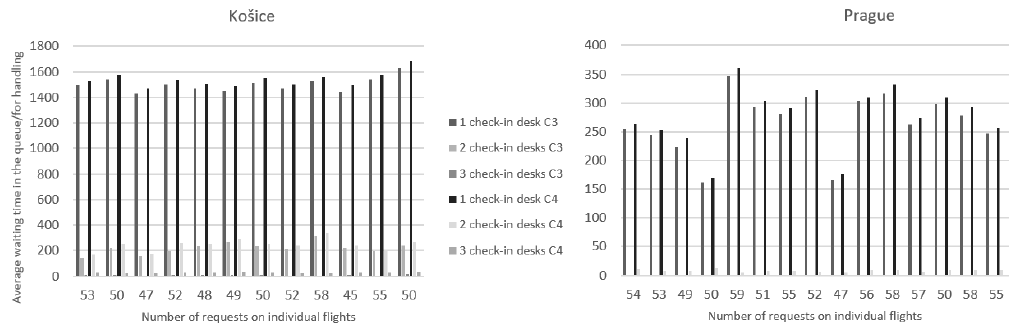
Figure 10. The average waiting time in the queue/for service when changing the number of service